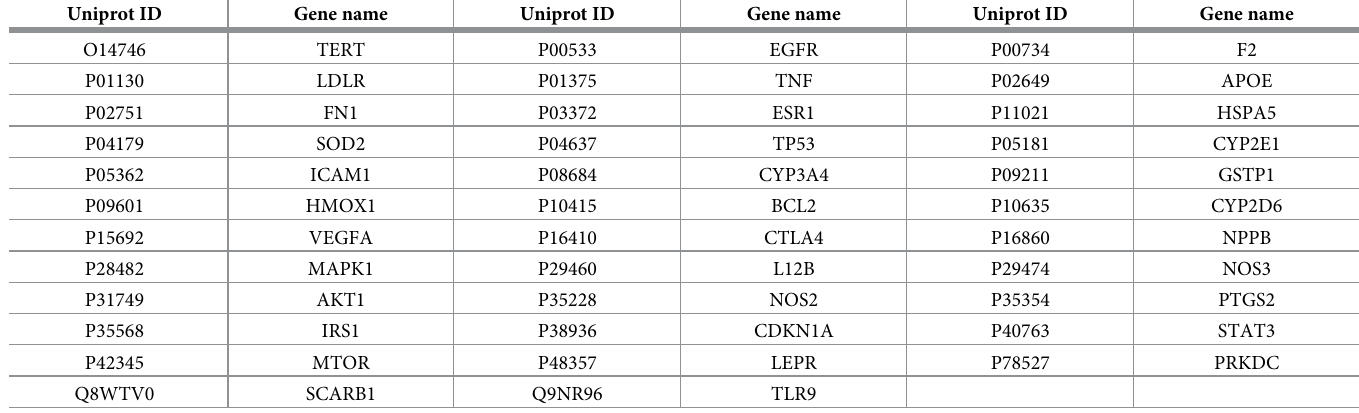
Table 6. Disease genes in set E associated with COVID-19 pathology. Uniprot